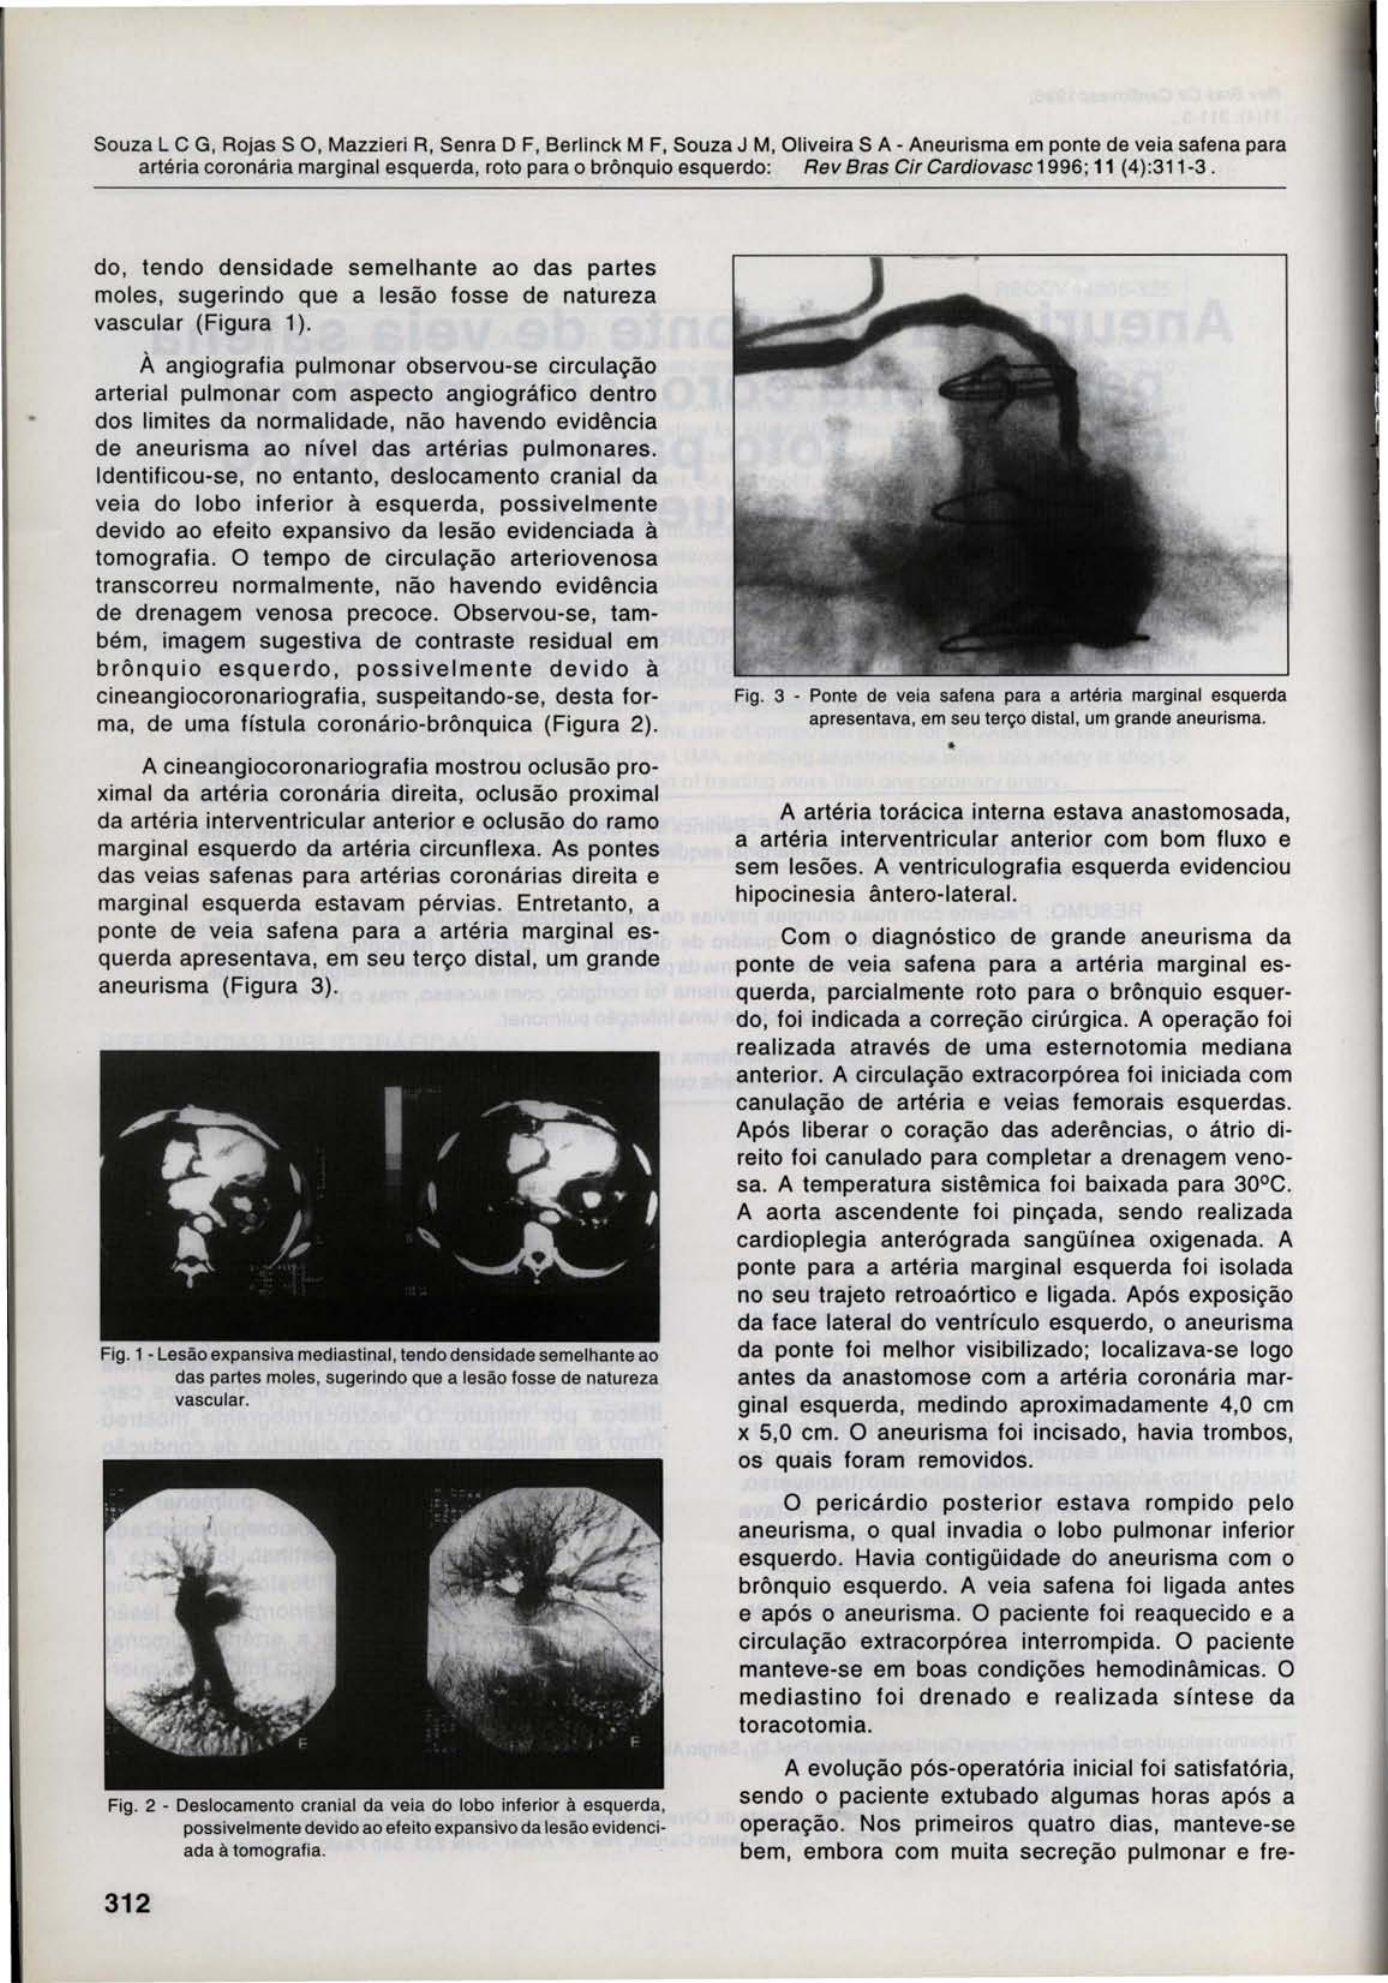
Fig. 2 - Deslocamento cranial da veia do lobo inferior à esquerda, possivelmente devido ao efeito expansivo da lesão evidenci ada à